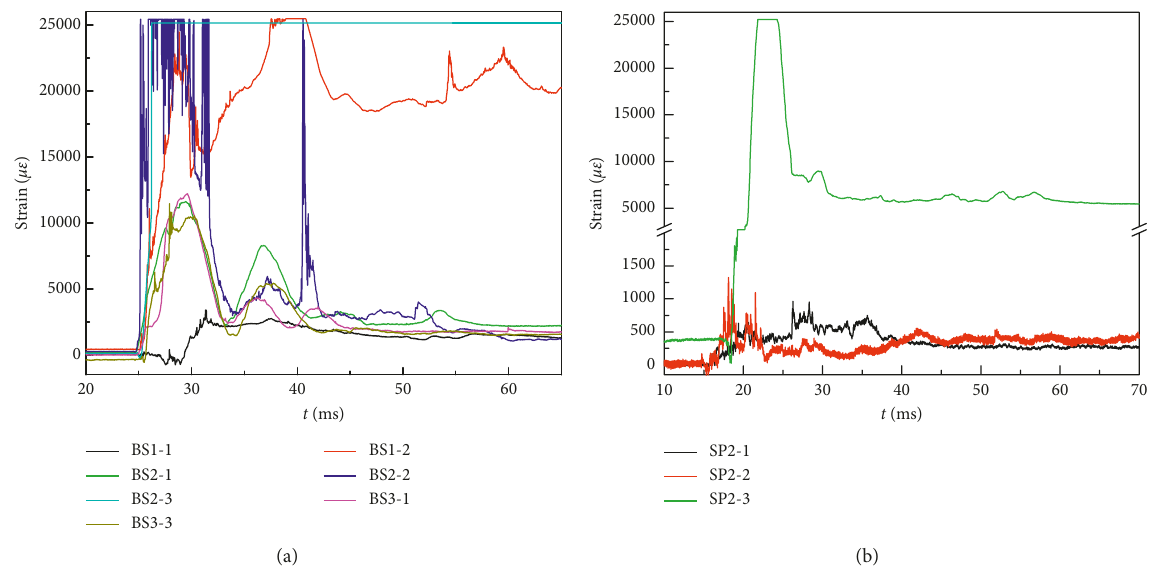
Figure 12: Strain history of the reinforcement (BCL). (a) BS specimens. (b) SP specimens.